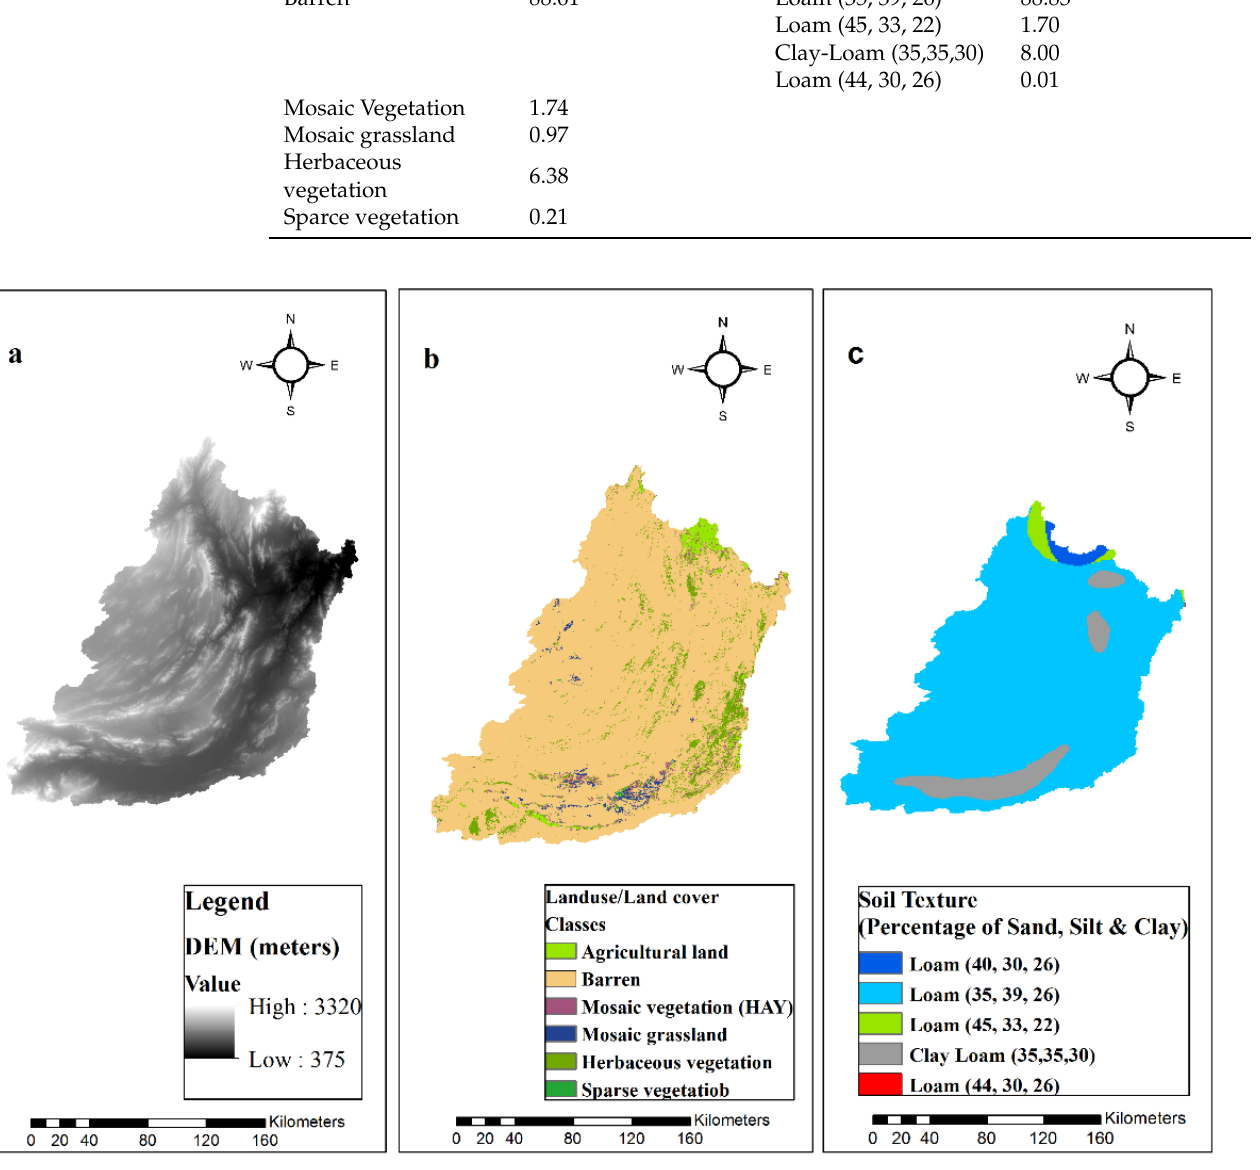
Table 3. Land use and soil type of study area. Land Use Type